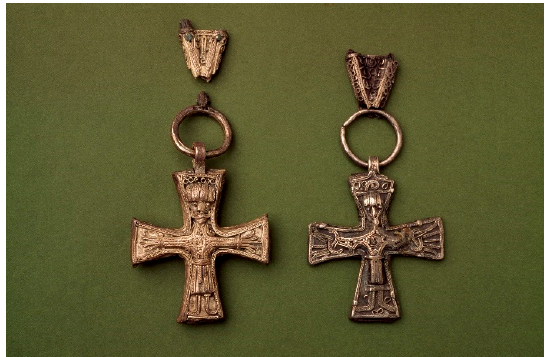
Figure 8. Crucifixes from Trondheim. Silver pendants, 11th century. Trondheim, NTNU University Museum, Inv. No. T16978A and T16978B. Photo: Per E. Fredriksen.